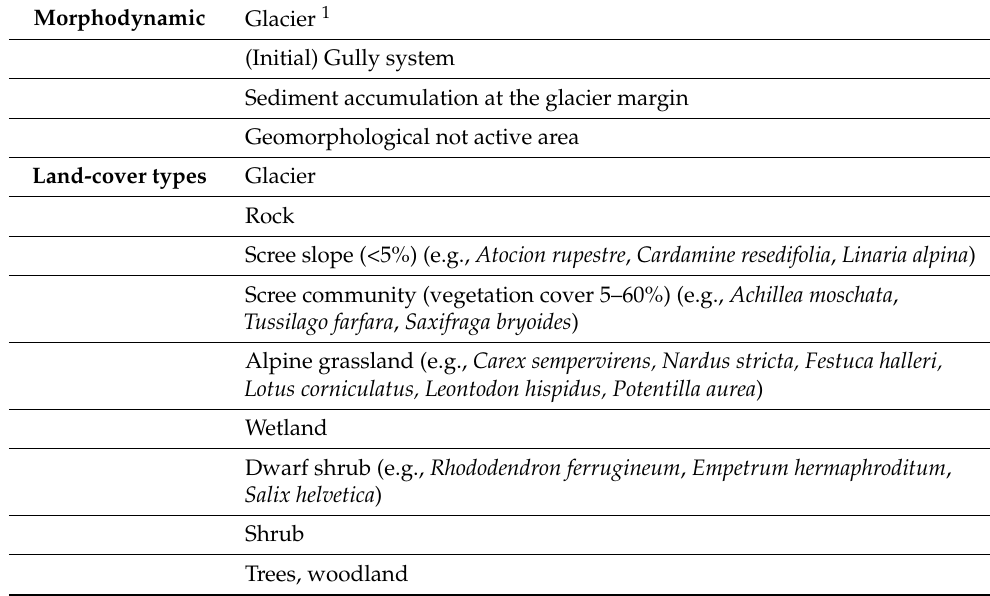
Table 3. Categories used for the morphodynamic and land-cover types mapping with the most abundant species per type based on vegetation surveys in 2020 in